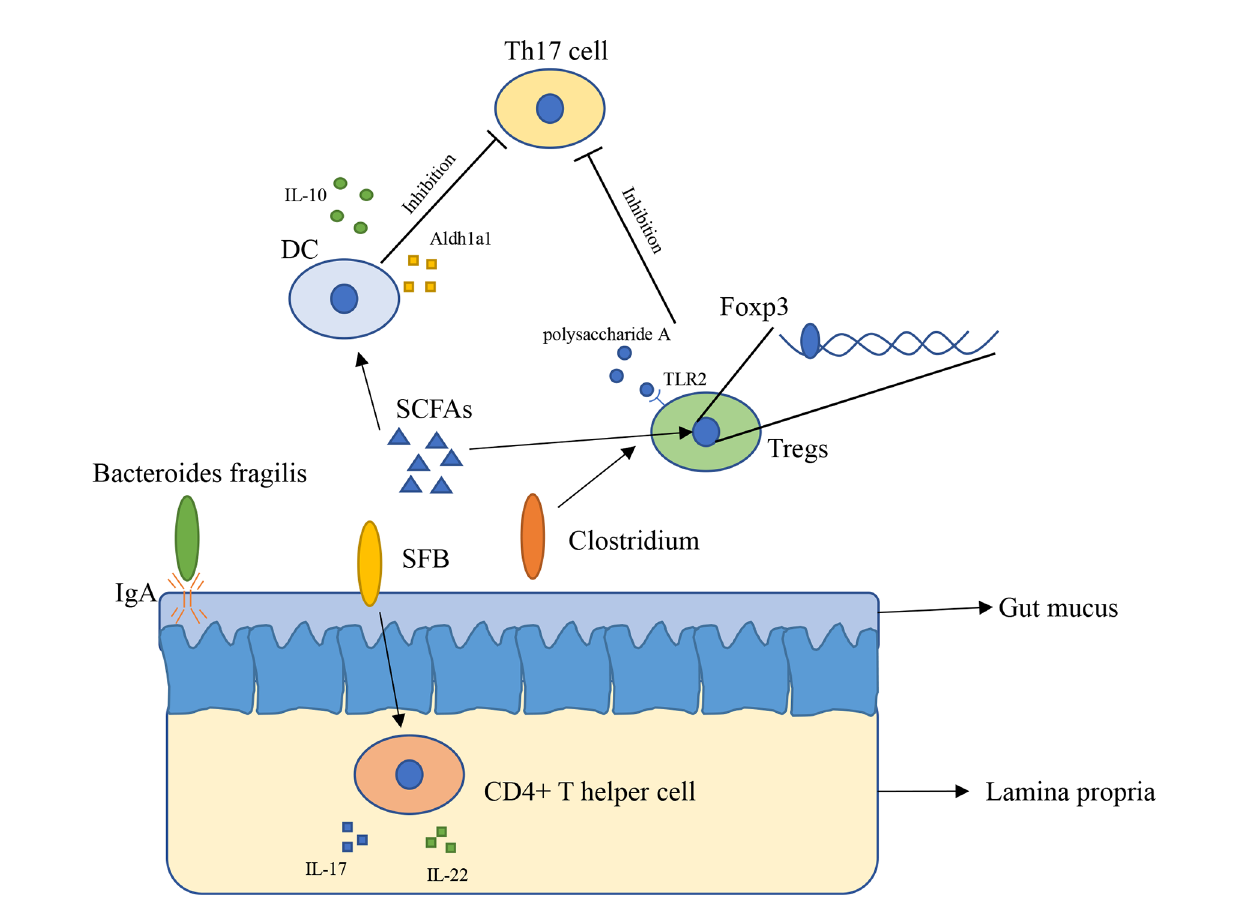
FIGURE 1 | The interaction between gut microbiota and immune system (1). Bacteroides fragilis takes advantage of IgA to settle down in the intestine of mice (2); SFB induces the appearance of CD4+ T helper cells in lamina propria (3); Clusters IV and XIVa of the genus Clostridium are associated with Tregs accumulation in colon (4); SCFAs regulate Foxp3 in Tregs, inhibit immune response of T cells (5); SCFAs induce expressing of IL-10 and Aldh1a1 in DCs, result in inhibiting the development of Th17 cell (6); Polysaccharide A secreted by Bacteroides fragilis binds to TLR2 in Tregs, enhances Tregs and suppresses the proin fl ammatory Th17